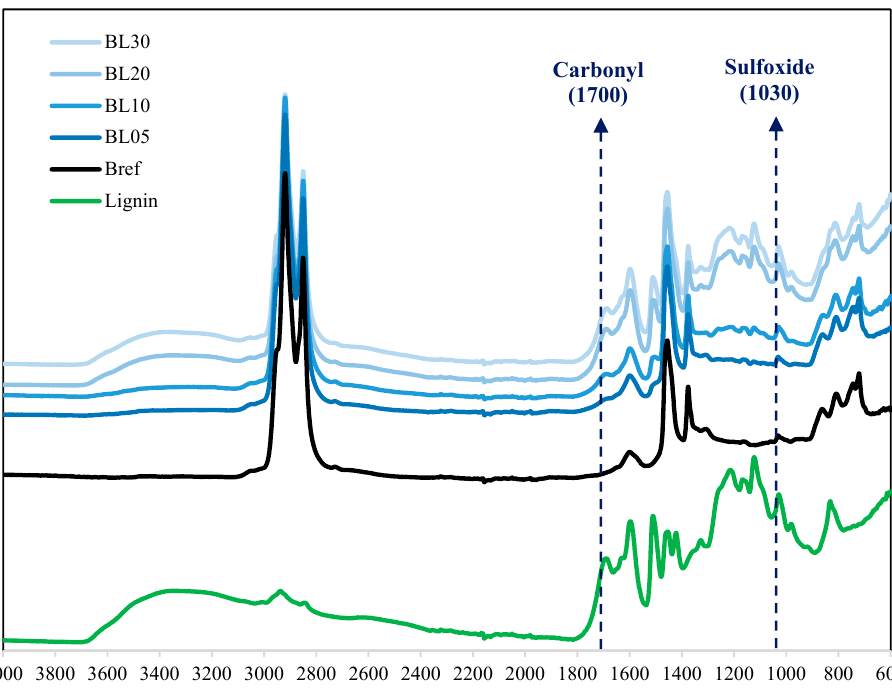
Figure 2. Fourier transform infrared spectroscopy (FTIR) spectra of lignin–bitumen systems.